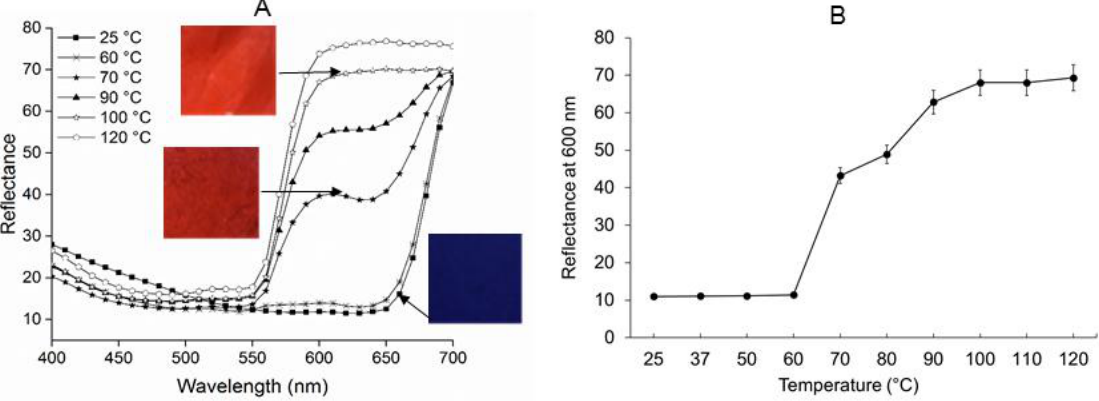
Figure 4. ( A ) Reflectance spectra of the selected PEO-PDA fiber (Fiber #9) treated at selected temperatures (25 °C, 60 °C, 70 °C, 90 °C, 100 °C, and 120 °C). The inserted photographs show the color of the fibers. The fibers treated at 70 °C began to exhibit colorimetric transition on both the reflectance spectra and the photograph. The color switch in the fiber was continuously developed until the temperature was 110 °C. No further change in either reflectance spectra or photograph was observed